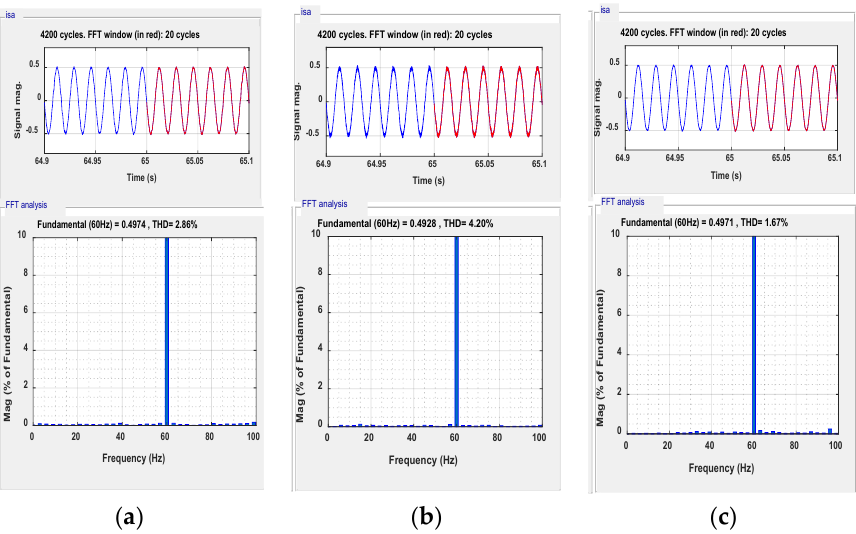
Figure 15. Stator current total harmonic distortion (THD) under: ( a ) PIC, ( b ) SMC, and ( c ) ABC.